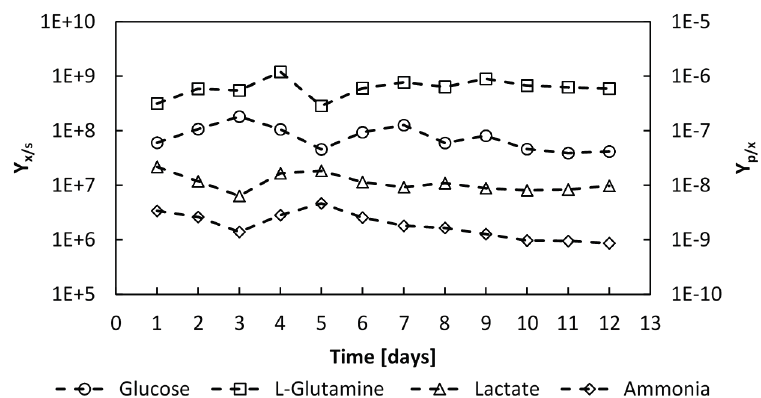
Figure 13. Evolution of the glucose and L -glutamine to number of cells yields Y X ⁄ S , and the produced lactate and ammonia to cells yields, Y P ⁄ X , over the whole culture period, expressed in (cells·mmol − 1 ) and (mmol·cell − 1 )